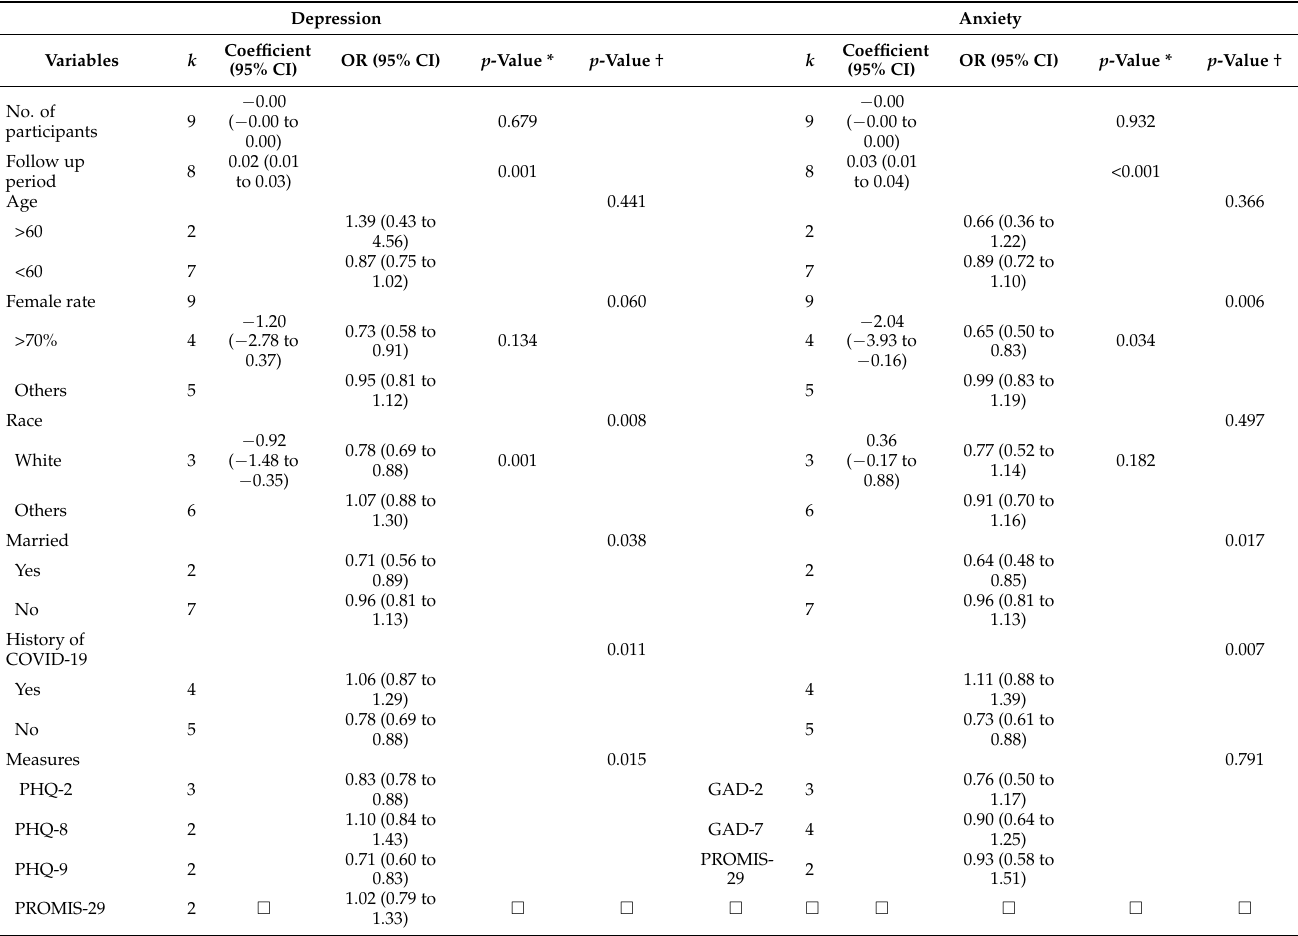
Table 3. Associations of moderators of depression and